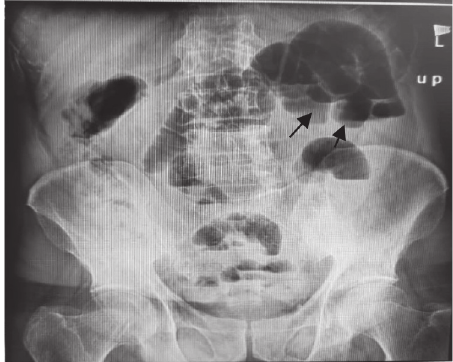
Figure 6: Male patient’s upright abdominal X-ray.